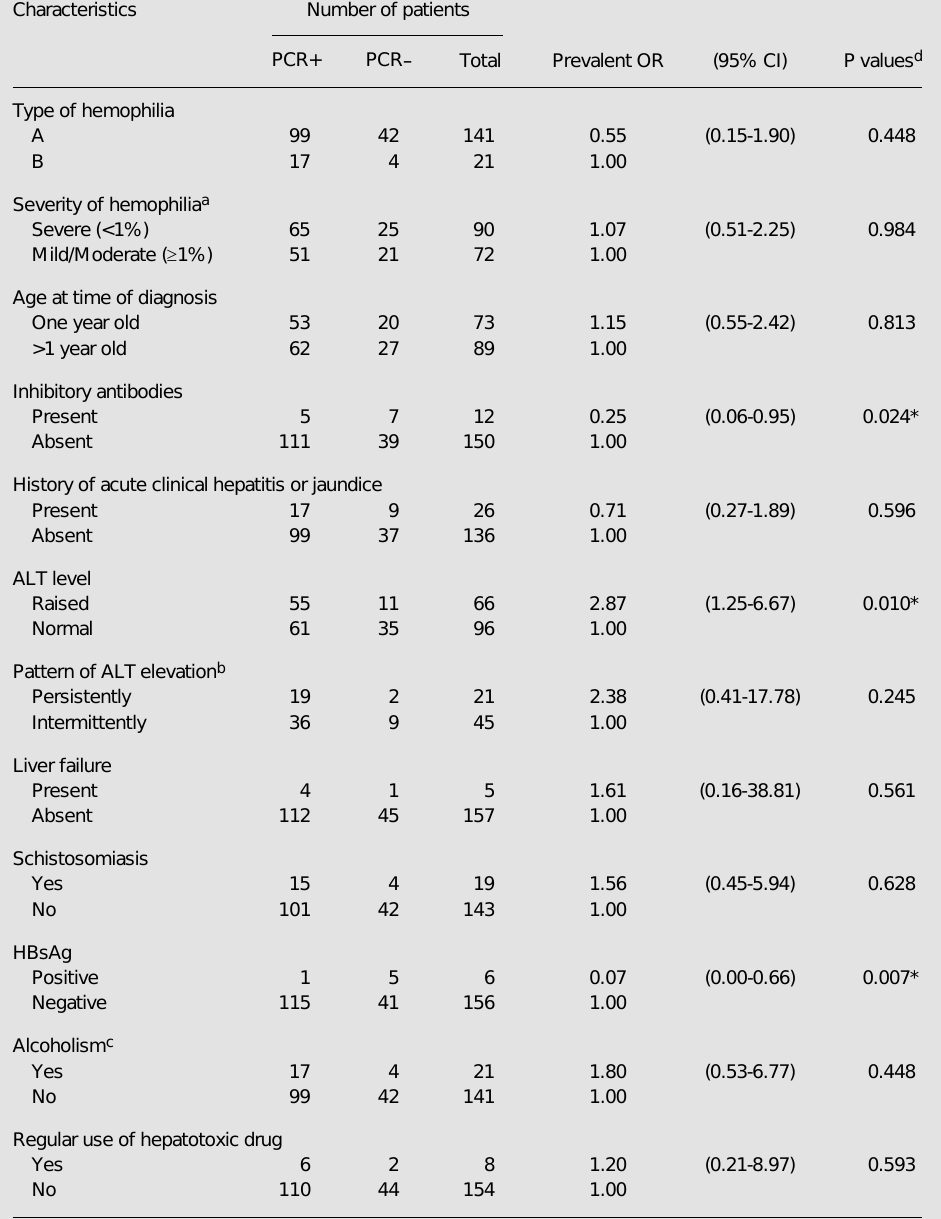
Table 1. Univariate analysis of positive anti-hepatitis C virus (HCV) hemophiliacs in terms of positivity to HCV- nested-RT-PCR and other